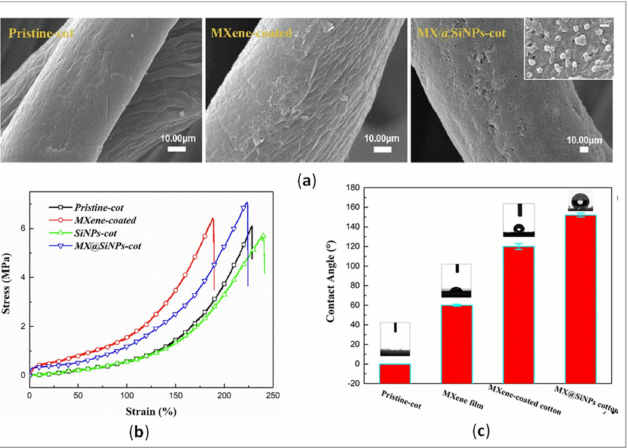
Figure 4. ( a ) SEM images of untreated cotton, MXene-coated and MXene@SiNPs-coated cotton, ( b ) Corresponding stress-strain results, and ( c ) Water Contact Angle (WCA) of samples (reprinted with permission from Ref. [3] Copyright 2022